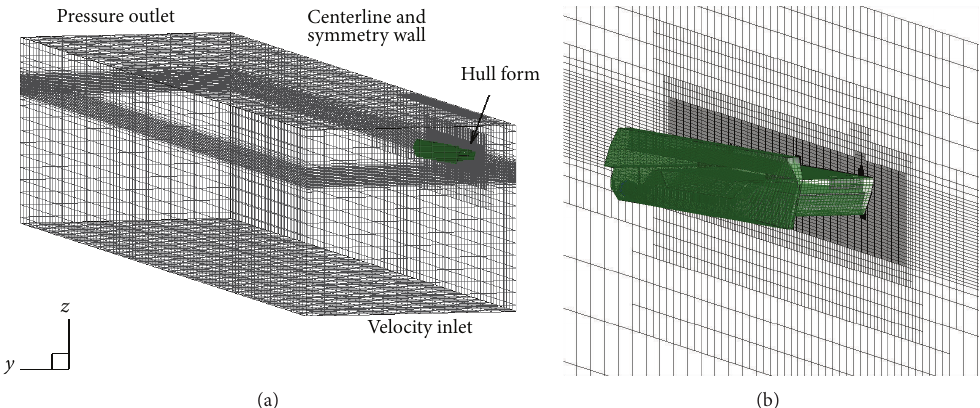
Figure 7: URANS computational domain for T-Craft analysis. (a) Full computational domain; (b) closeup view of trimmed hexahedral surface mesh on the hullform.